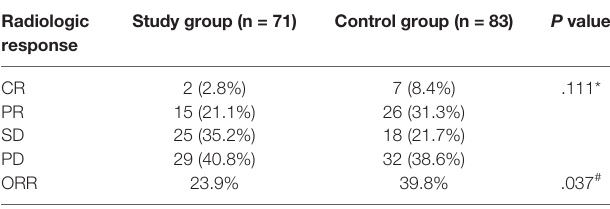
TABLE 3 | Radiologic response and ORR of the two groups.